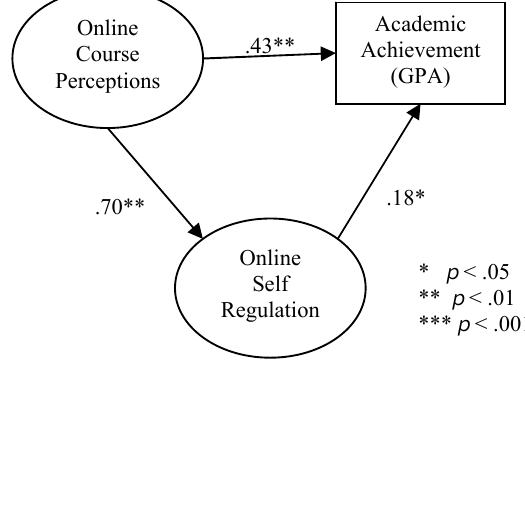
Figure 1. Path diagram with online learning self-regulation as a